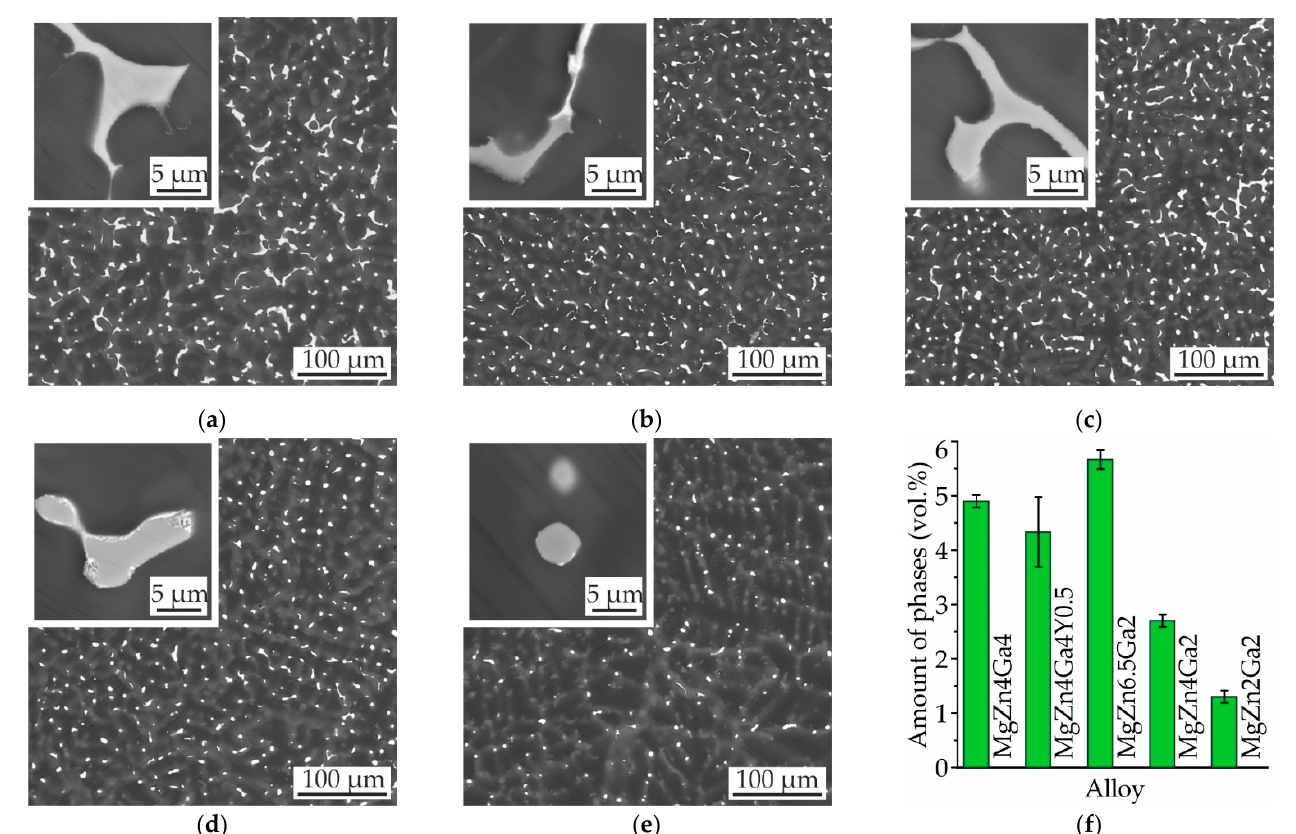
Figure 1. SEM micrographs of ( a ) MgZn4Ga4, ( b ) MgZn4Ga4Y0.5, ( c ) MgZn6.5Ga2, ( d ) MgZn4Ga2, and ( e ) MgZn2Ga2 alloys. ( f ) Intermetallic-phase contents of the as-cast alloys.